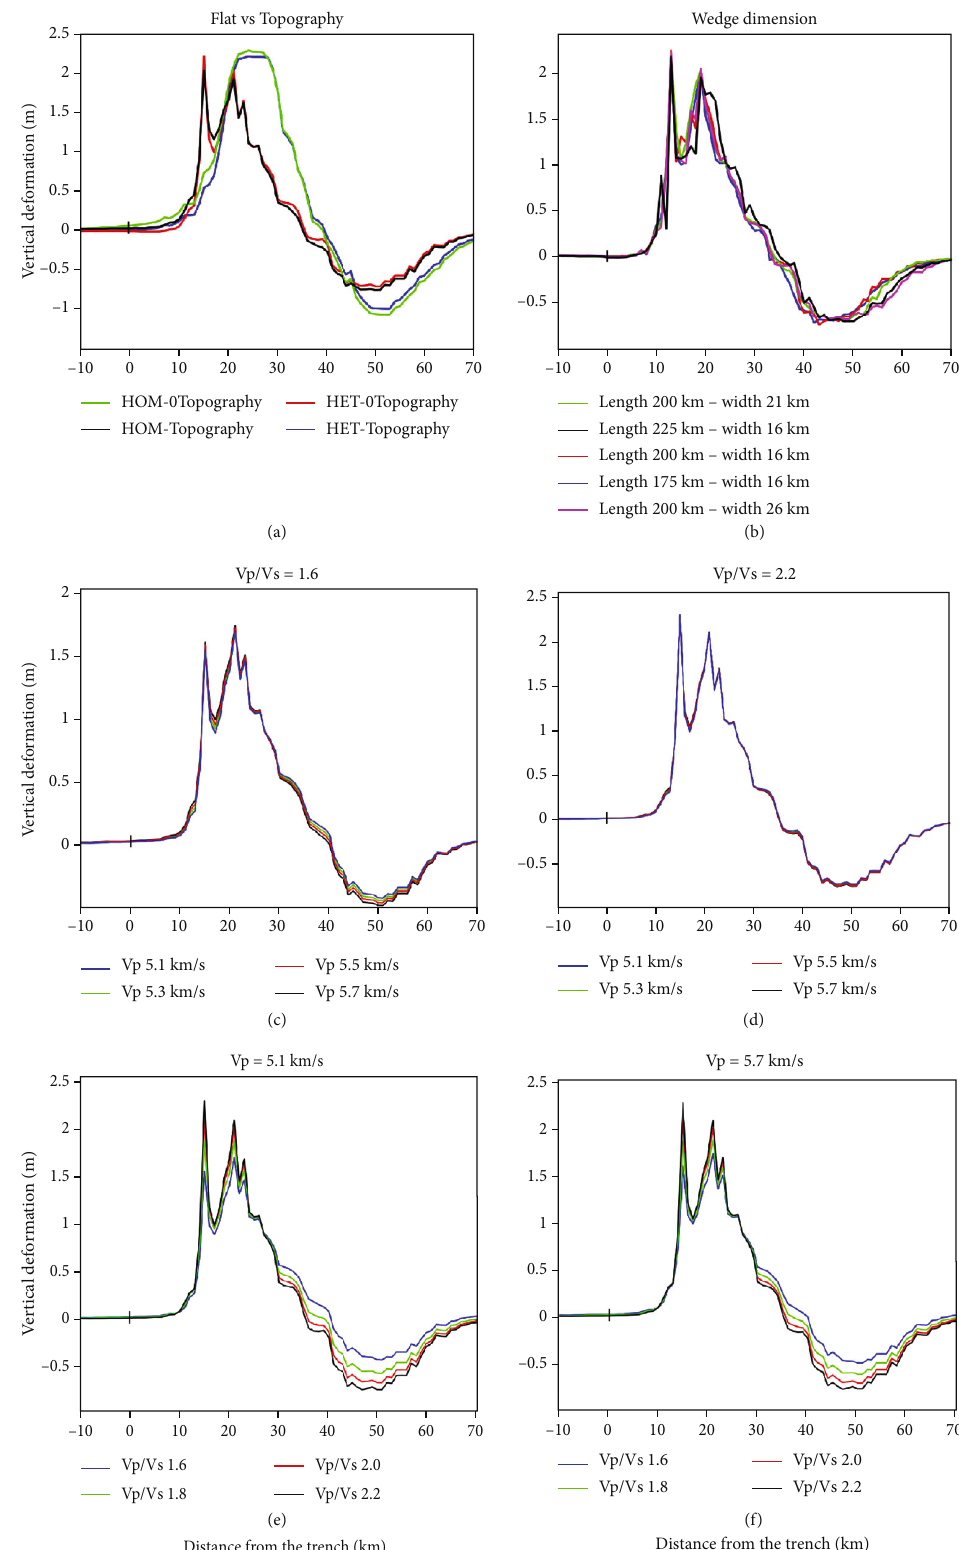
Figure 7: The vertical deformation at the cross-section shown in Figure 1. The fl at vs topography model with homogeneous and heterogeneous medium. (b) The wedge dimension variation model. (c) The model with constant Vp/Vs 1.6 and Vp variation 5.1-5.7km/s. (d) The model with constant Vp/Vs 2.2 and Vp variation 5.1-5.7km/s. (e) The model with constant Vp 5.1km/s and Vp/Vs variation 1.6-2.2. (f) The model with constant Vp 5.7km/s and Vp/Vs variation